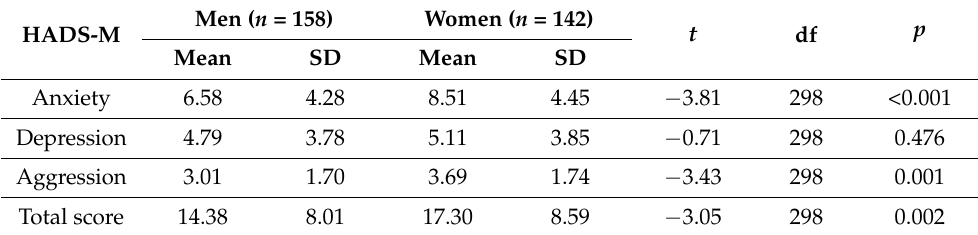
Table 2. HADS-M scores with regard to the subjects’ gender.